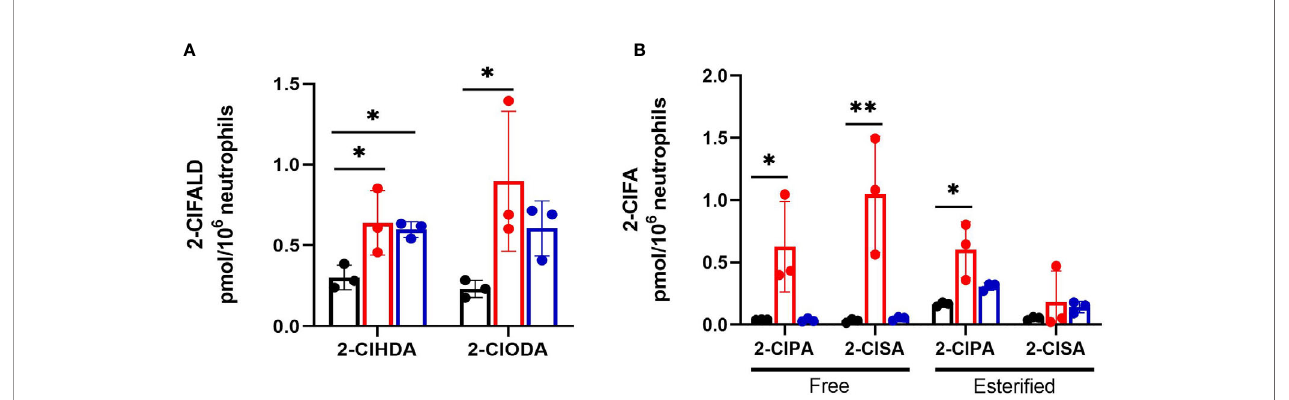
FIGURE 1 | 2-ClFALD and 2-ClFA production in cocultures of neutrophils with CFT073 and JM109 E. coli strains. 2x10 6 /ml neutrophils were incubated with either no bacteria (control, black), or, CFT073 (red) or JM109 (blue) strains of E. coli at a neutrophil: E. coli ratio of 1:10 for 30 min at 37°C. 2-ClFALD (A) as well as free and esteri fi ed 2-ClFA (B) were quanti fi ed as described in “ Materials and Methods ” . Data are from three neutrophil donors (biological replicates, 1 female, 2 males). 2-ClHDA, 2-ClODA, 2-ClPA, and 2-ClSA are 2-chlorohexadecanal, 2-chlorooctadecanal, 2-chloropalmitic acid and 2-chlorostearic acid, respectively. Multiple comparisons were performed using one-way ANOVA with Dunnett ’ s multiple comparison test. Error bars represent ± SD, p-value: ** < 0.01; * <